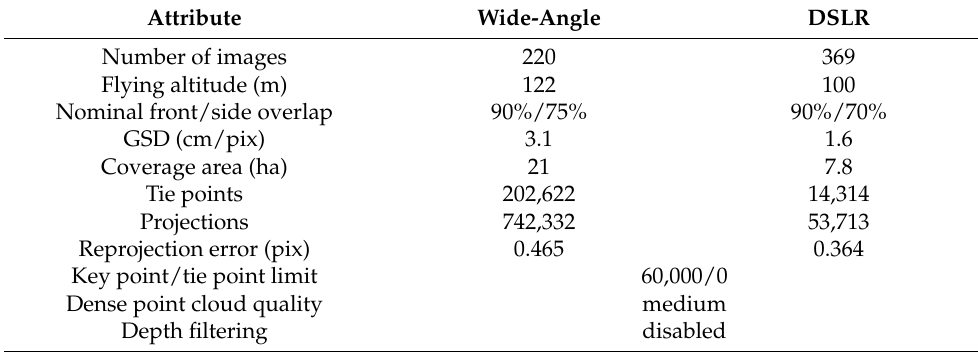
Table 1. Summary of wide-angle and DSLR image processing in Agisoft PhotoScan